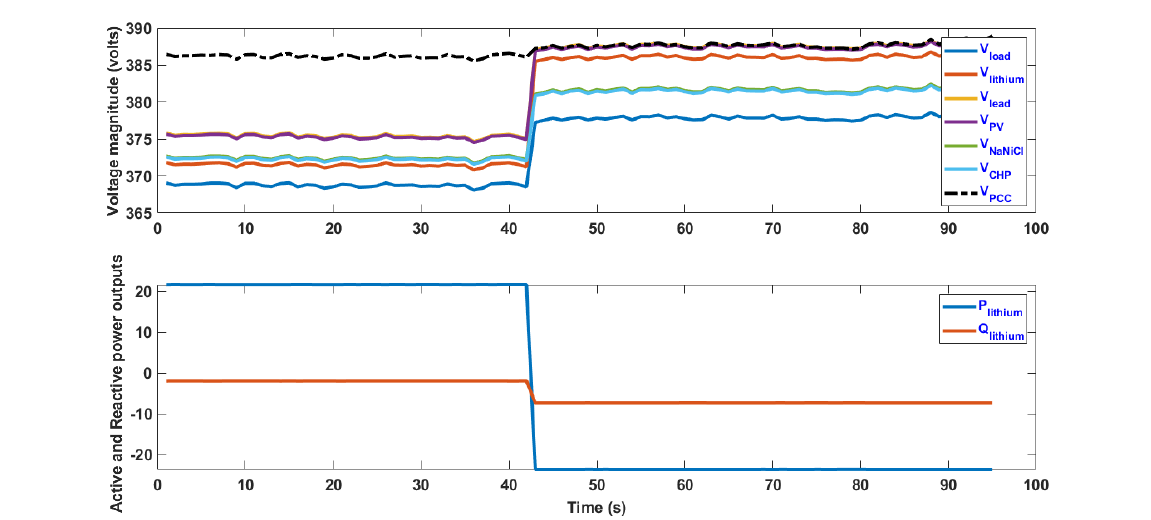
Figure 4. Voltage magnitude in test system over time and active and reactive power outputs in undervoltage condition and with the control of only a lithium-ion